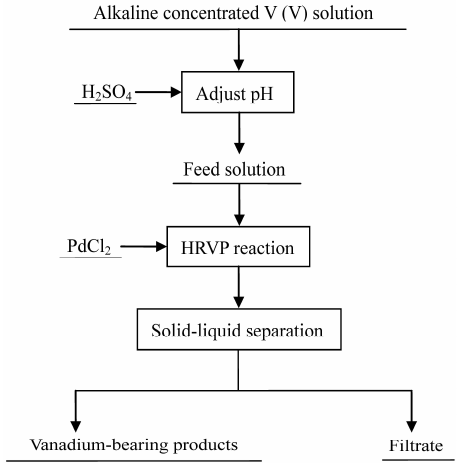
Figure 2. The hydrothermal hydrogen reduction technology (HRVP) process used in this study [20].